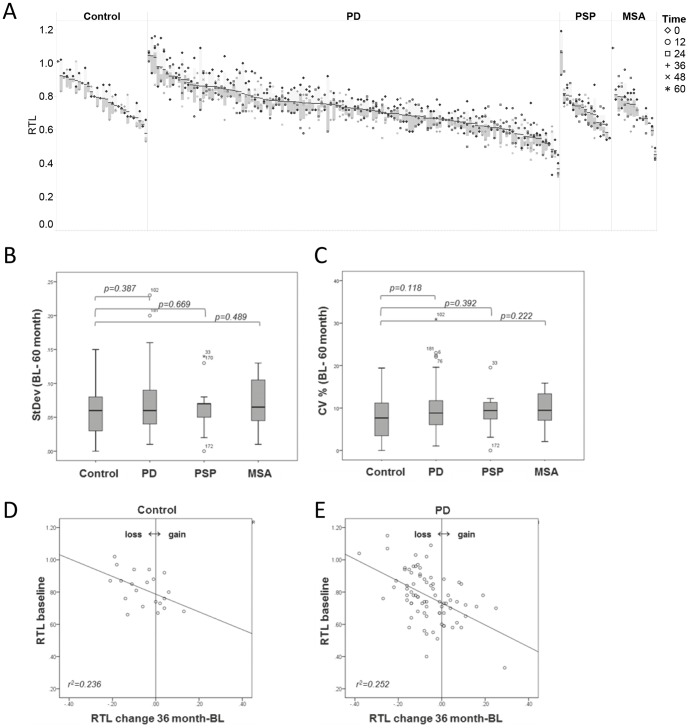
Telomere length dynamics.A) Individual relative telomere length (RTL) at diagnosis and at repeated follow up for up to five years in control, PD, PSP and MSA groups. RTL quartiles marked in each individual. B–C) Std.Dev (B) and CV% (C) of RTL in control, PD, PSP and MSA groups from baseline and up to five years follow up. D–E) Individuals RTL change between baseline and three year follow up in control (D) and PD (E).